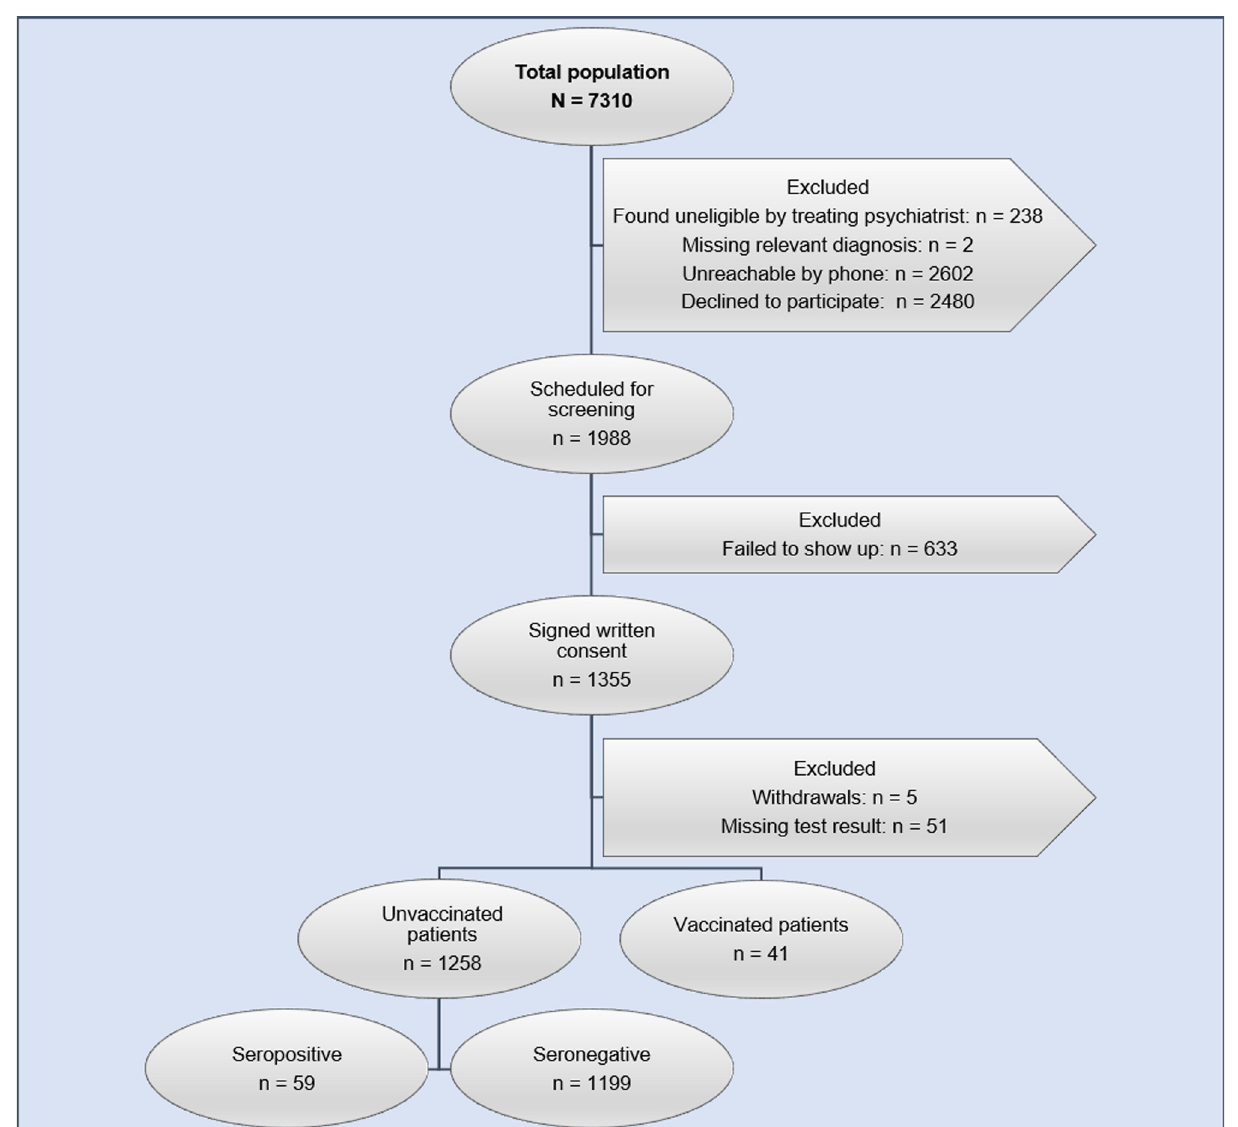
Fig 1. Flowchart of patients with severe mental illness. All unvaccinated patients with severe mental illness who fulfilled all criteria to be enrolled in the study, and with a positive or negative SARS-CoV-2 antibody test result, were included in the statistical analysis.